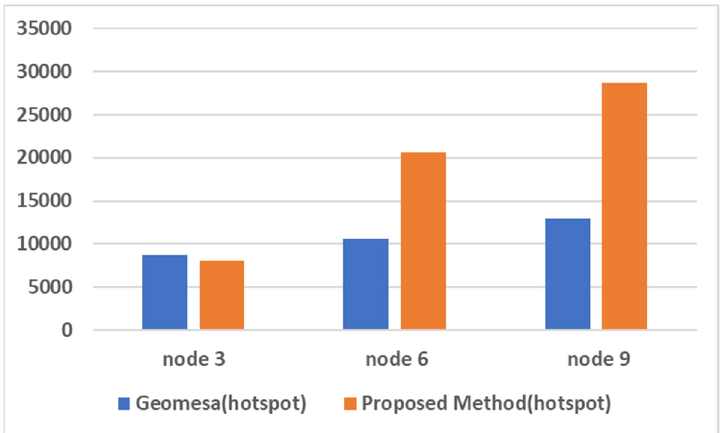
Figure 13. Range query throughput of Geomesa and the proposed method (Range query throughput: number of range queries per second).